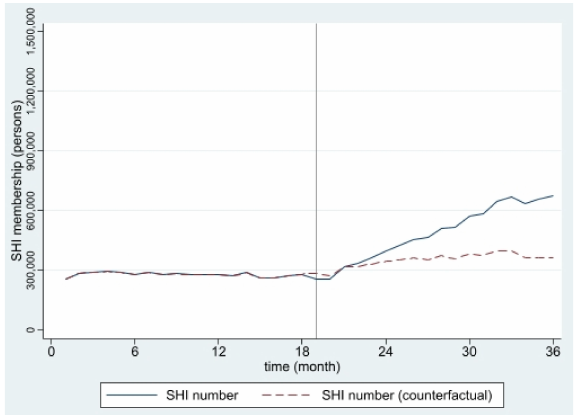
Figure 3. SHI membership, Greater Bangkok